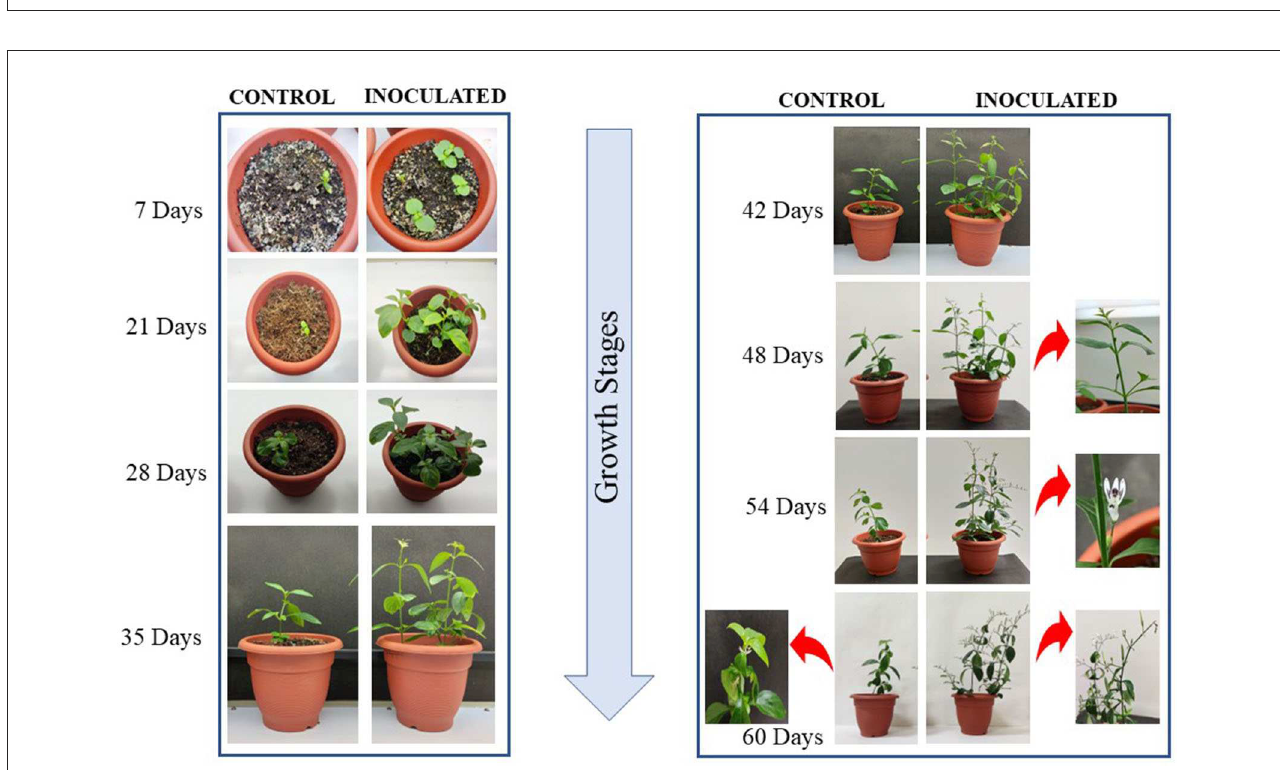
FIGURE4 Plant growth and morphology at different growth stages of development in A. paniculata grown in pots under controlled conditions. Growth stages are depicted from days 7 to